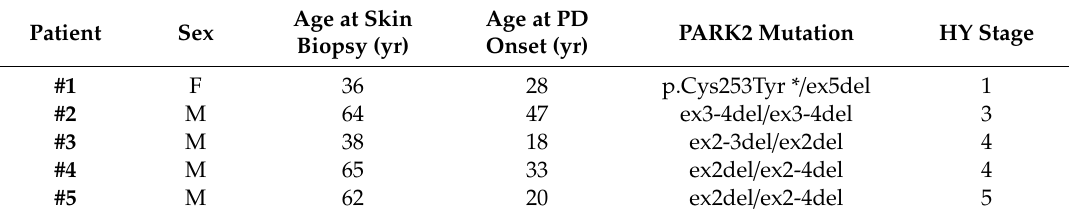
Table 2. Sex, age at skin biopsy, age at PD onset, genotypic characteristics and disease severity following the Hoehn and Yahr (HY) scale for five patients enrolled in this study. The control is a 53 years old